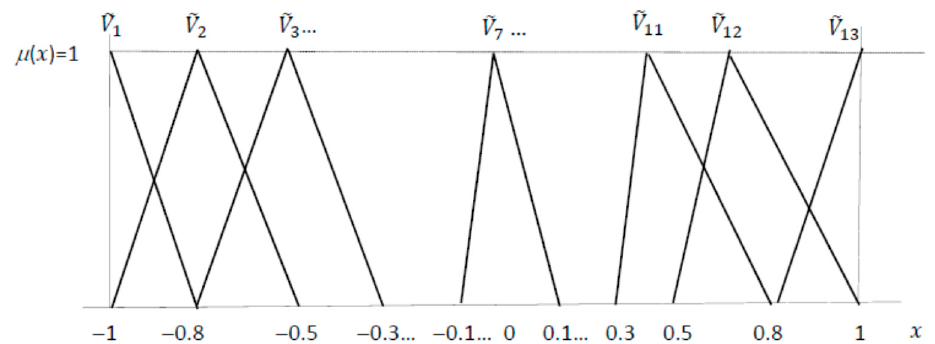
Figure 1. Linguistic variable “coefficient of correlation” built up from the scale by the Department of politics of Quinnipiac University. Source: own elaboration by using [28], Akoglu, H. (2018). User’s guide to correlation coefficients. Turkish Journal of Emergency Medicine , 18 (3), 91–93. Table 2. Fuzzy linguistic variable “coefficient of correlation” built up from de Quinnipiac University scale. Negative Correlation Positive Correlation Fuzzy Number Linguistic Label Fuzzy Number Linguistic Label